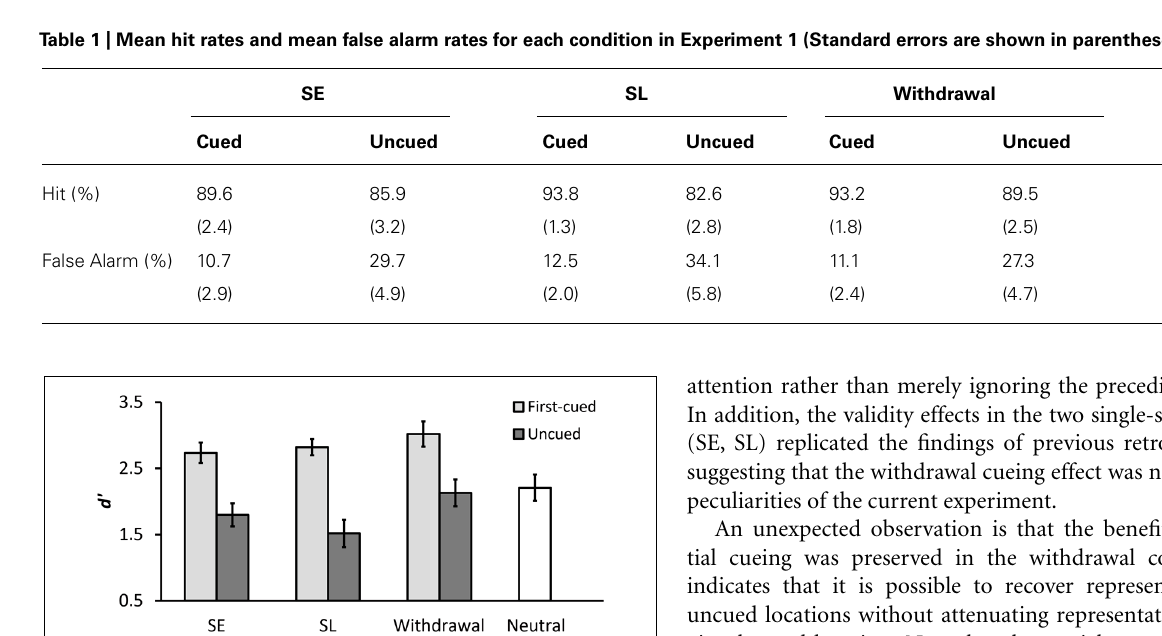
vs. SL: t (15) = 4.12, p = .003]. It is important to note that